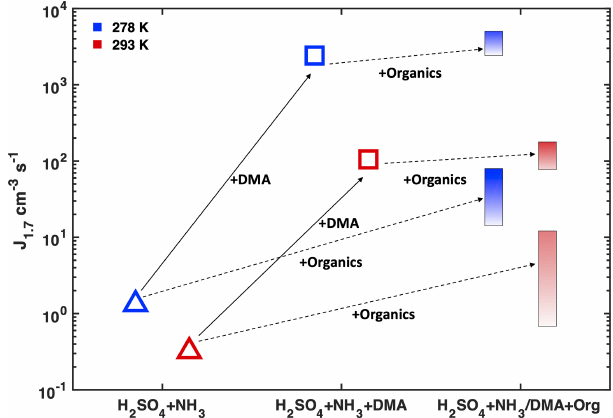
Figure 3. Simplified scheme of NPF rates in polluted environments showing the effect of adding different vapours on H 2 SO 4 –NH 3 nucleation at two different temperatures. All points have similar H 2 SO 4 ((8 ± 2) × 10 7 cm − 3 ) and NH 3 (1–2ppbv). The leftmost points are measured with only SO 2 and NH 3 added to the cham- ber, and each step to the right represents the addition of one more component to the system. Solid arrows describe the addition of ca. 4pptv DMA; dashed arrows describe the addition of aromatic hydrocarbons. Increasing colour intensity of bars indicates increas- ing production rate of highly oxidized organics. cent ambient measurements in Shanghai (Yao et al., 2018).